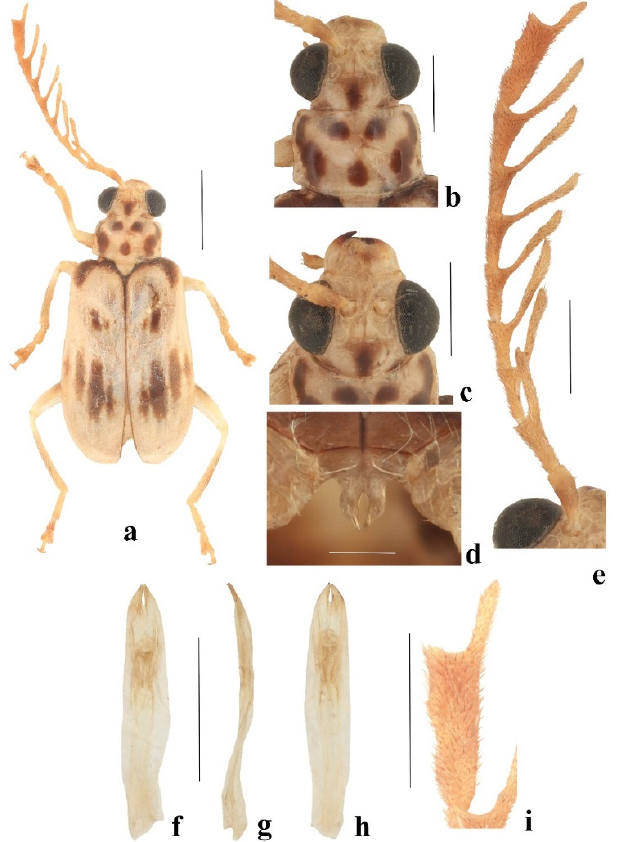
Figure 8. Taumacera mirabilis (Jacoby, 1887): ( a ) male; ( b ) head and pronotum, dorsal view; ( c ) head, frontal view; ( d ) male metasternal process; ( e ) left antenna; ( f ) aedeagus, dorsal view; ( g ) aedeagus, lateral view; ( h ) aedeagus, ventral view; ( i ) antennomere X, detail. (Scale bars: ( a ) = 2 mm, ( b , c , e – i ) = 1 mm, ( d ) = 0.3 mm).